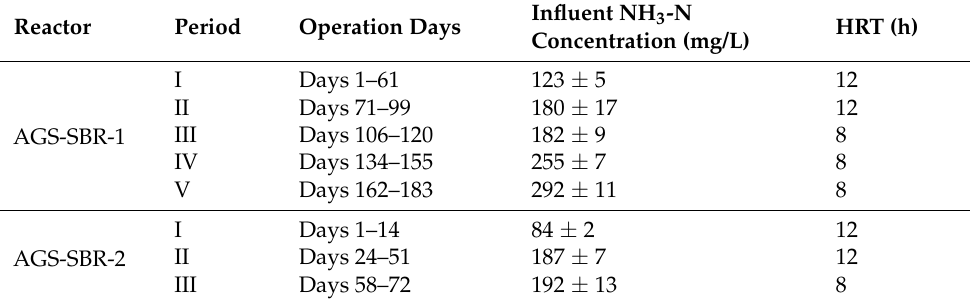
Table 3. Summary of reactor operational parameters for AGS-SBR-1 & 2.